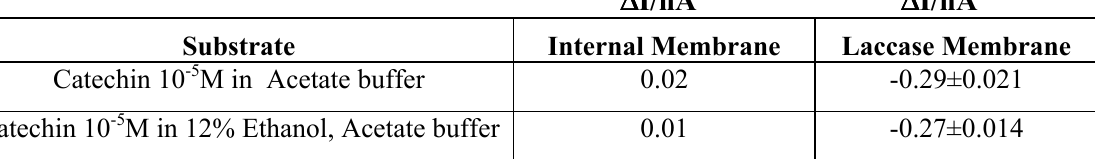
Table 1. Response of the electrode base system to catechin in aqueous and 12% ethanol, acetate buffer.